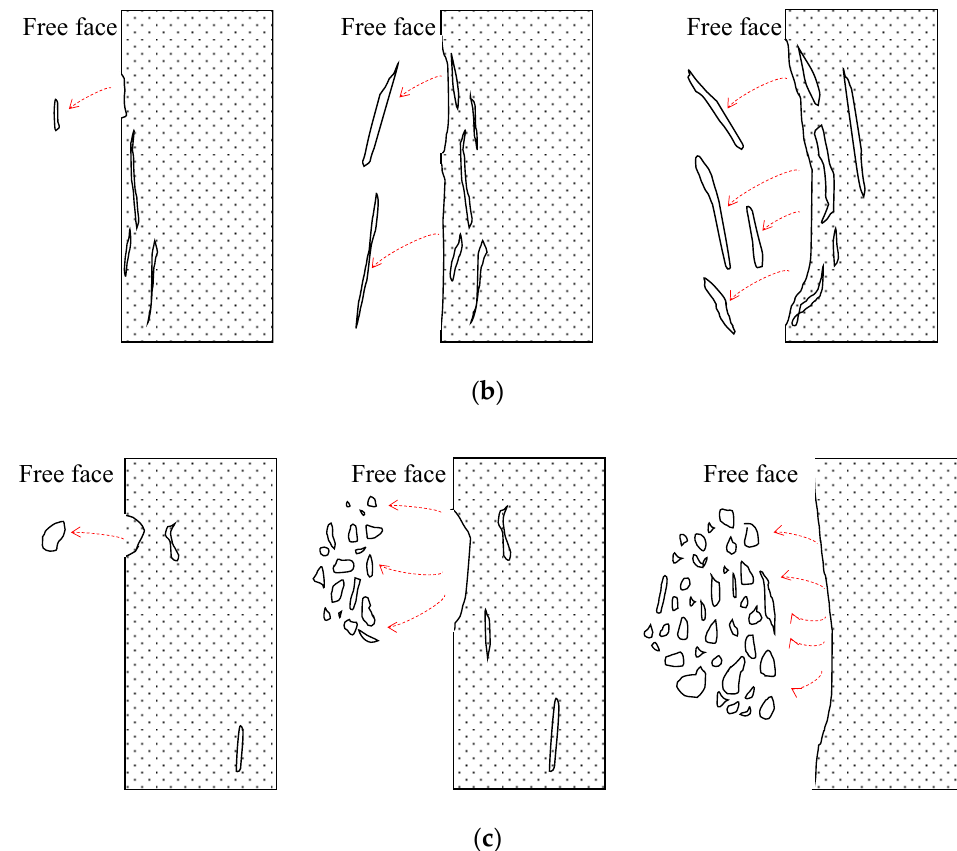
Figure 13. Characteristics of coal burst pit: ( a ) static load; ( b ) cyclic load; ( c ) transient load.